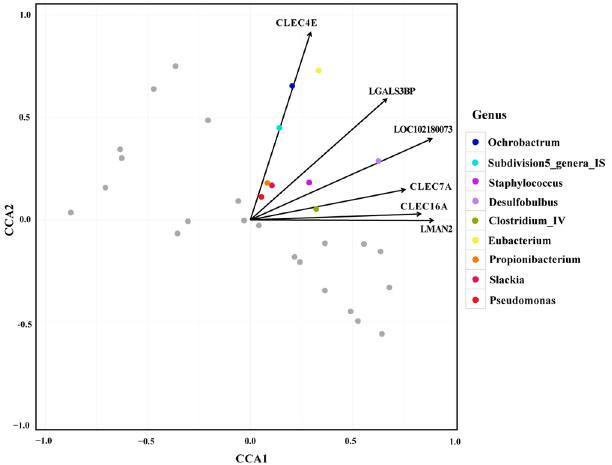
Figure 4. Constrained correspondence analysis revealing the correlations between the relative abundance of the reduced microbial clades and the expression of the functional lectin